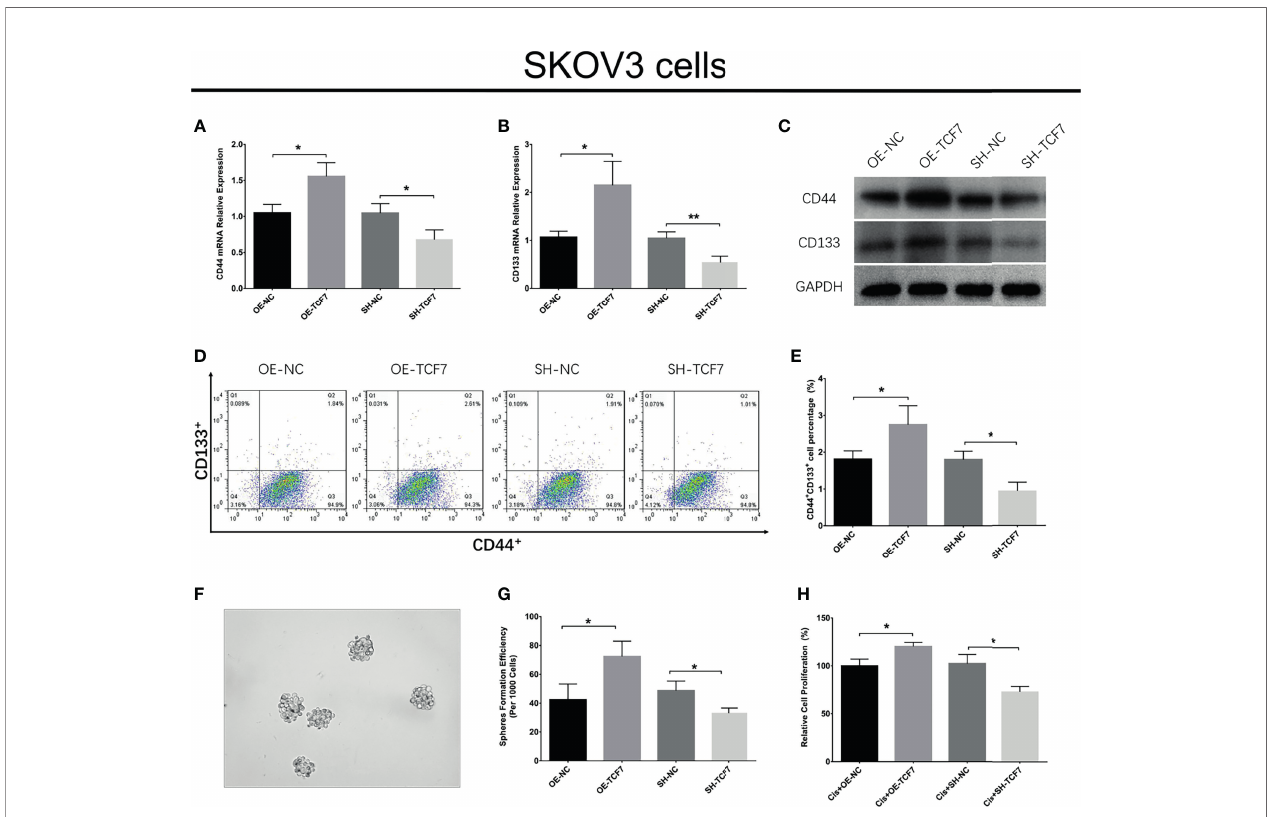
FIGURE 2 | Effect of lnc-TCF7 on cell stemness in SKOV3 cells. (A, C) CD44 expression after transfection; (B, C) CD133 expression after transfection; (D, E) CD44 + CD133 + cell percentage after transfection; (F, G) spheres formation ef fi ciency after transfection; (H) drug resistance to cisplatin after transfection. Experiments were performed in triplicates. * represented P < 0.05, ** represented P <